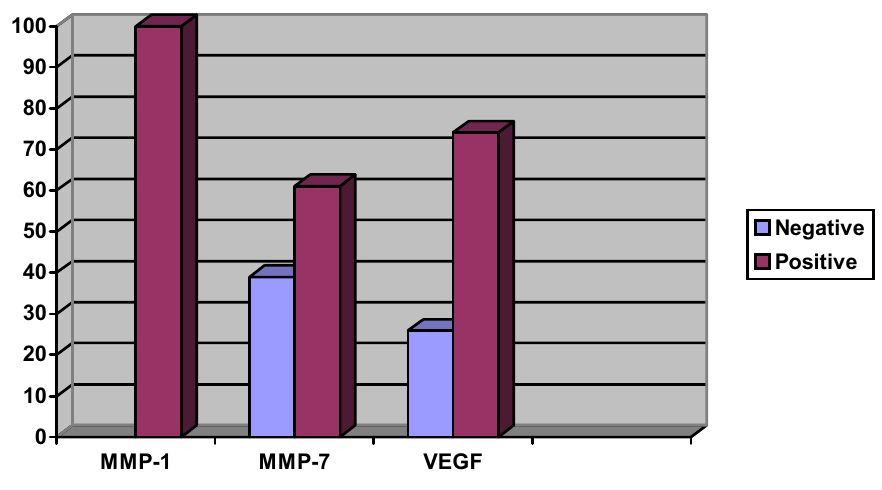
FIGURE 1 – Distribution of tumor expressions of MMP-1, MMP-7 and VEGF